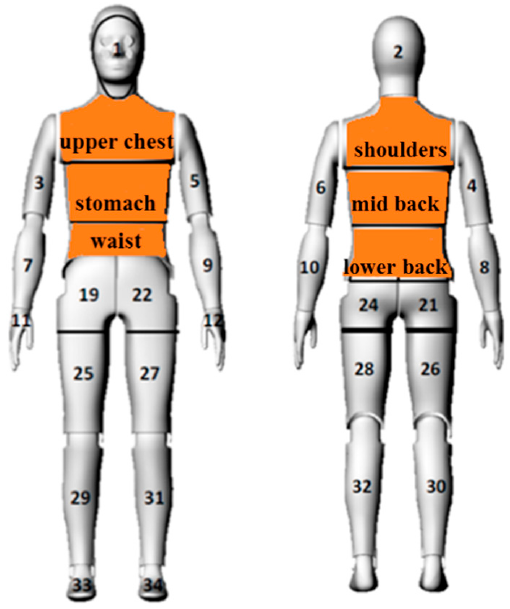
Figure 4. Manikin segments subjected to heat flux density analysis. Before the test, the undergarments and outerwear were in the laboratory (in unfolded condition). The temperature values in the laboratory were controlled to avoid activation of the PCM. The average air temperature in the laboratory was 24 ± 2 ◦ C. (variants I and II) are shown in Figure 5.